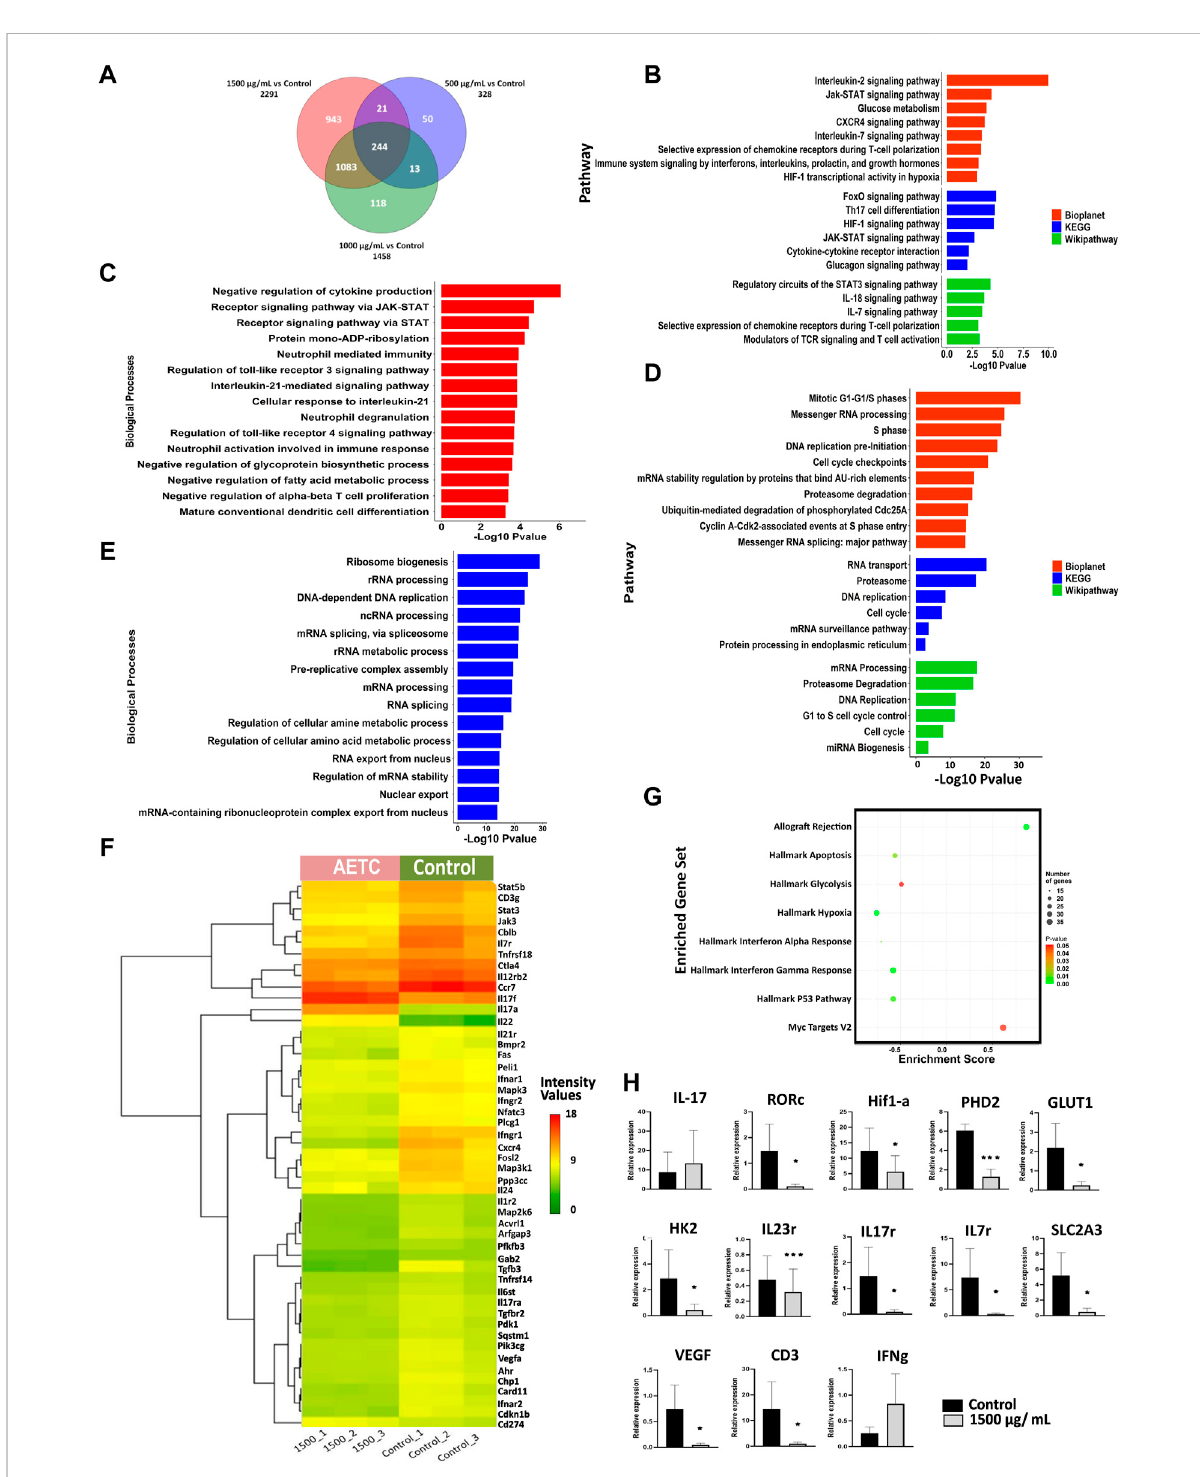
FIGURE 3 Differential gene expression pattern contributing towards inhibition of Th17 cell differentiation on AETC treatment. (A) Venn diagram representing the total number of differentially expressed genes and common genes at different doses of AETC. (B) Enriched pathways in downregulated and (D) upregulated genes after AETC treatment at 1500 μ g/ml compared to vehicle control. (C) Enriched biological processes in downregulated and (E) upregulated genes after AETC treatment at 1500 μ g/ml compared to vehicle control. (F) Heatmap representing genes differentially regulated and involved in Th17 cell differentiation, HIF1 signaling, Cytokine-cytokine receptor interaction, T cell receptor signaling pathway, Signaling by interleukins, and Interleukin-7 signaling pathway. The differentially regulatedgenes with FC ≥ 2 or ≤ 2 and a p -value < .05 were